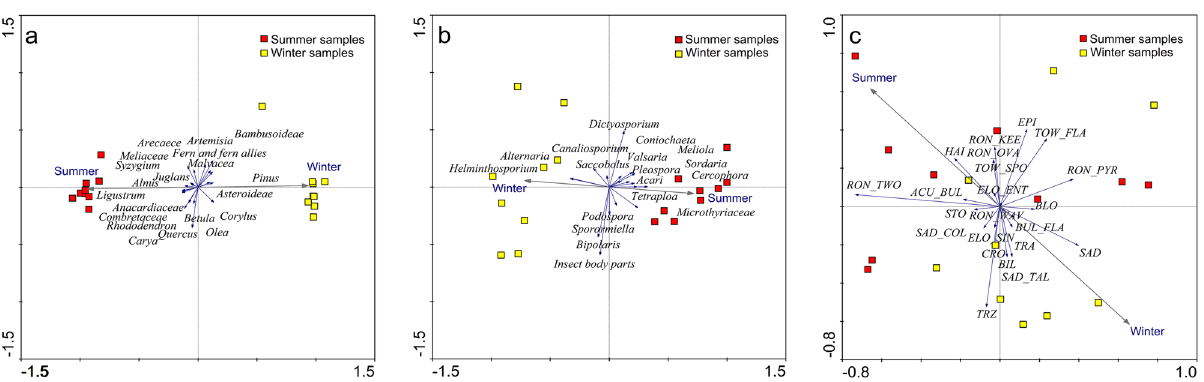
Figure 3. Comparative PCA ordination plots for the ( a) pollen, ( b) NPP and ( c) phytoliths recovered in the summer and winter faeces